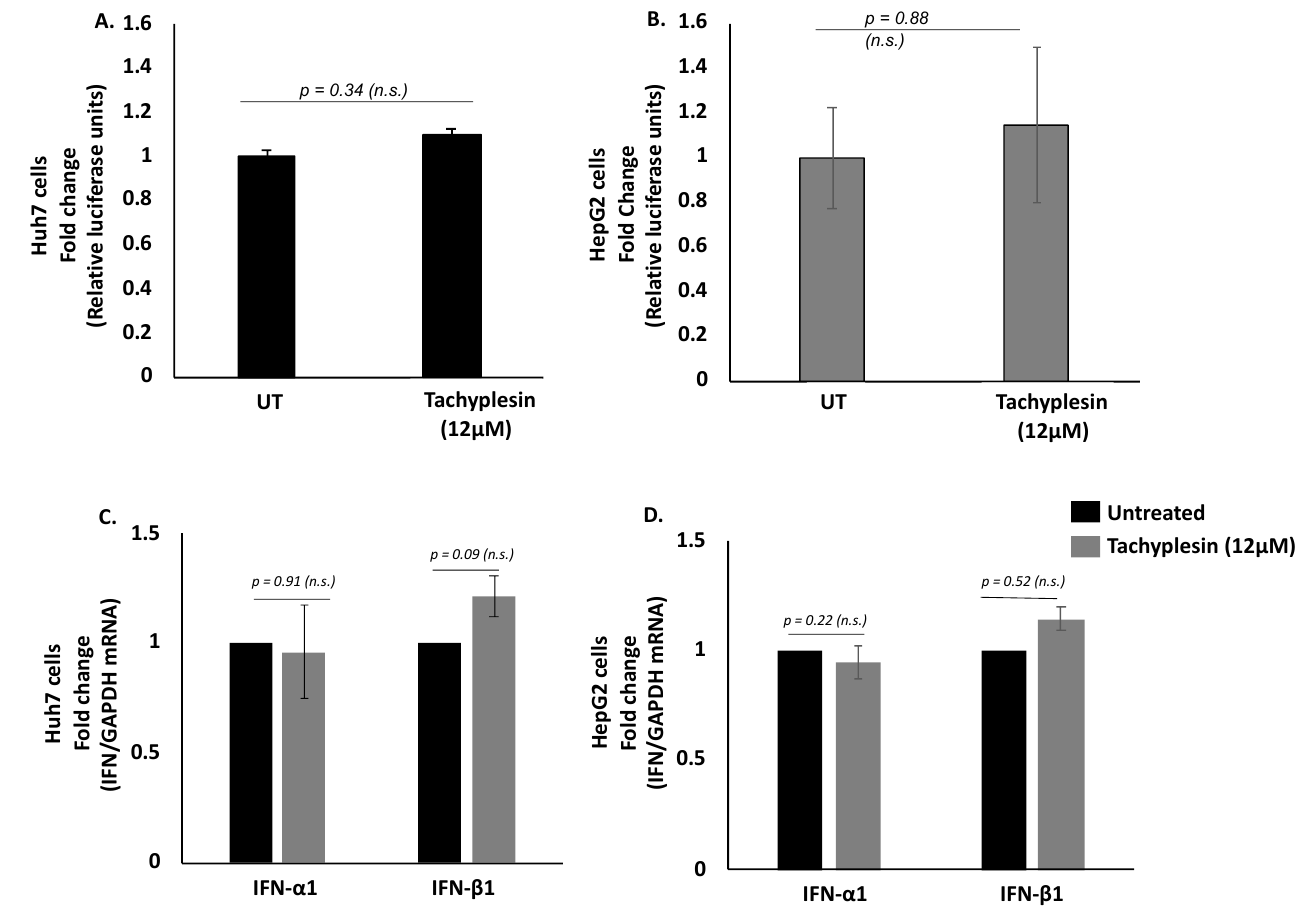
Figure 3. Dual-luciferase assay and IFN-1 expression level. Relative luciferase expression in ( A ) Huh7 and ( B ) HepG2 cells transfected with psiCHECK-2 dual-luciferase ( Renilla /firefly) reporter vector following 48 h incubation with 12 µ M of Tachyplesin. No significant change was observed in levels of IFN- α1 and IFN - β1 ( C ) Huh7 cells and ( D ) HepG2 cells treated with 12 μM of Tpl. n.s : non-significant, p represents p- value.